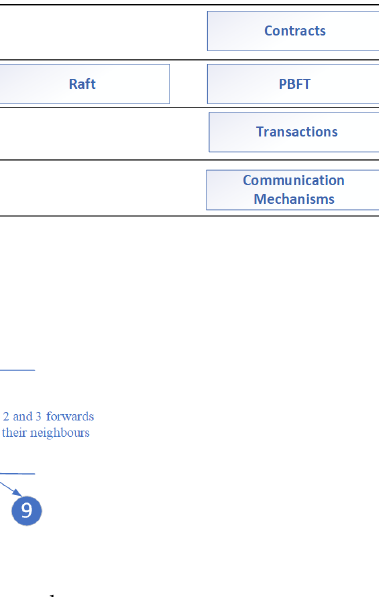
Figure 4. The Gossip Dissemination